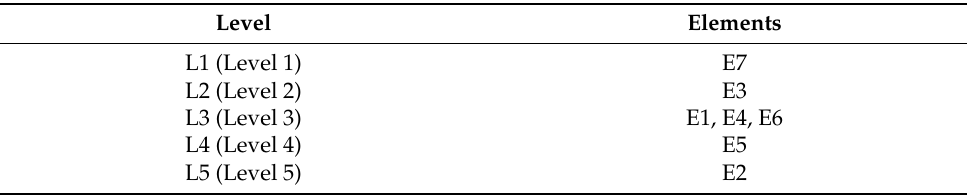
Table 8. Five levels and the corresponding elements for